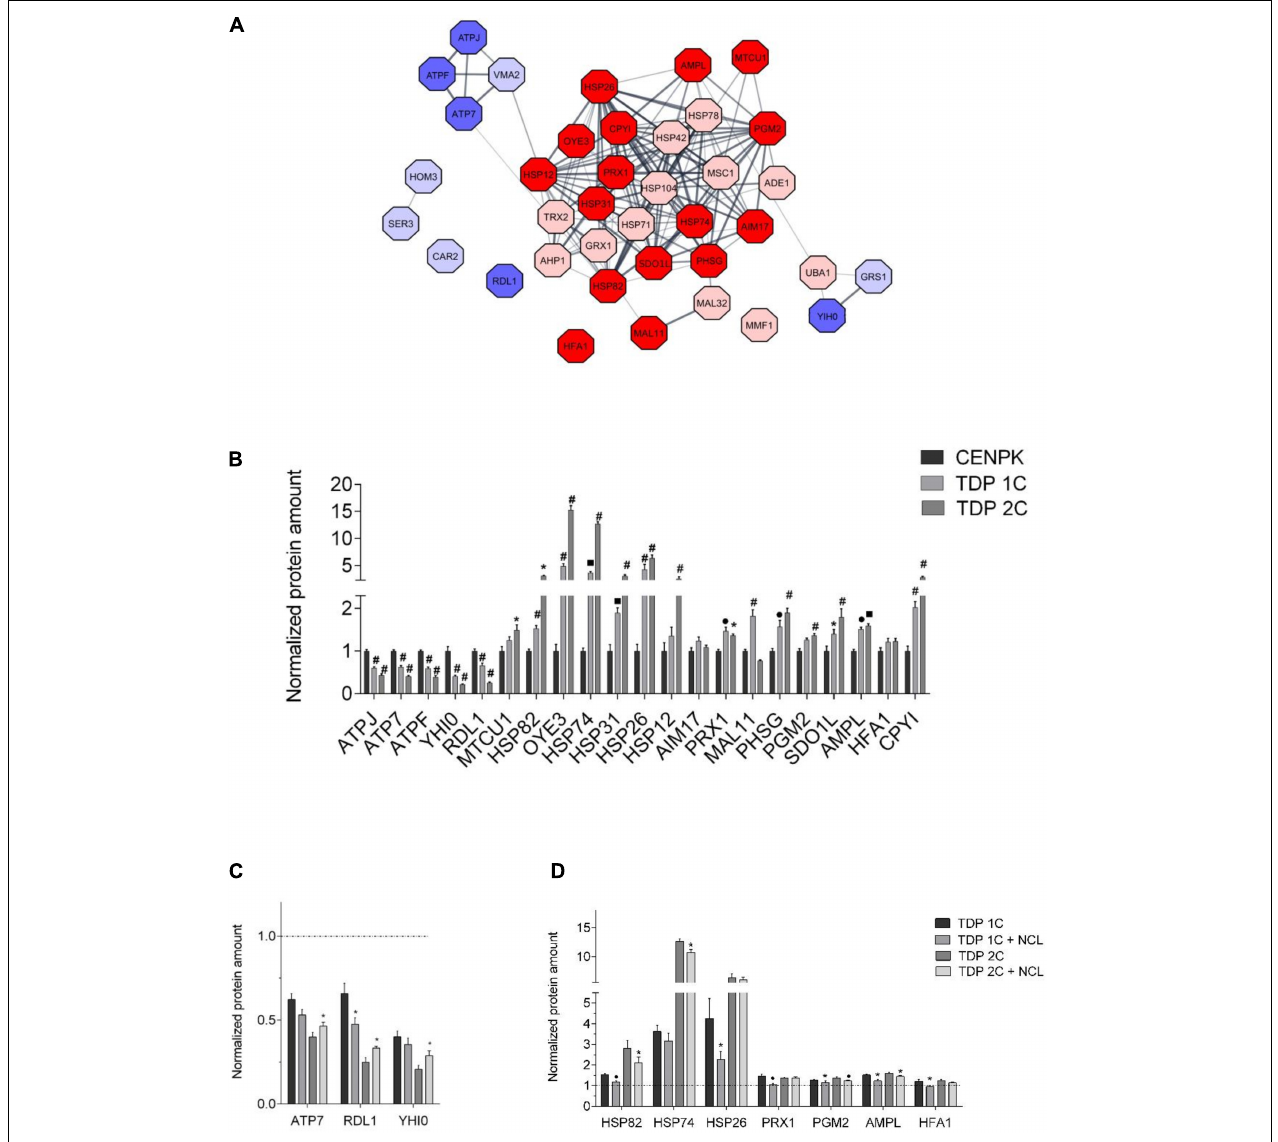
FIGURE 6 | NCL rescues the expression of some proteins altered by TDP-43 in yeast cells. (A) Protein interaction network of the 38 proteins found to be differentially expressed (cut-off of TDP 1C/CENPK ratio > 1.33 or < 0.77) in the TDP 1C strain by the tandem mass tag MS/MS-based analysis. Up- and down-regulated proteins in TDP 1C are represented as red or blue nodes, respectively, with color intensity being representative of TDP/CENPK ratio value (i.e., dark red and blue colors indicate a TDP-43/CENPK ratio > 1.50 or < 0.66, respectively, for a total of 21 proteins). The thickness of lines indicates the strength of association between protein nodes. (B) The relative abundance of the 21 proteins found to be mostly highly altered in the TDP 1C strain by the above untargeted proteomic approach was assessed by parallel reaction monitoring (PRM) assay in both TDP 1C and TDP 2C strains. Protein amounts are normalized to those measured in the control CENPK strain. n = 9; * p < 0.05, • p < 0.01, (cid:4) p < 0.001, # p < 0.0001, two-way ANOVA with Holm–Sidak correction for comparison of TDP 2C and TDP 1C to CENPK. (C) The effects of NCL-mKate2 expression on the abundance of down-regulated (left panel) or up-regulated (right panel) proteins in the TDP 1C and TDP 2C strains were assessed by PRM analysis. (D) Protein amounts are normalized to those measured in the CENPK strain (dashed line). n = 9; ∗ p < 0.05, • p < 0.01 two-way ANOVA with Holm–Sidak correction for comparison of TDP 1C to TDP 1C + NCL and TDP 2C to TDP 2C +